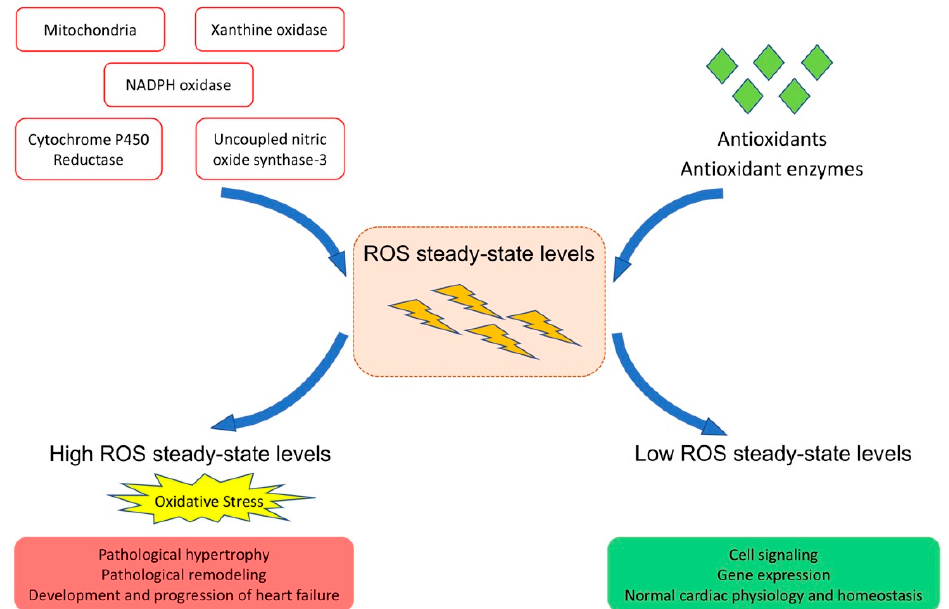
Figure 1. Role of ROS in cardiac physiology and pathophysiology. Under physiological condi- tions, there is an exquisite balance between ROS production and ROS degradation resulting in low steady-state ROS levels. Low levels of ROS have a physiological role in the modulation of excitation- contraction coupling in adaptive processes like physiological cardiac hypertrophy, and in cardiac homeostasis. Oxidative stress resulting from an increase of steady-state ROS levels results in mala- daptive processes such as detrimental effects on cardiomyocyte electrophysiology, capillary rare- faction, interstitial and perivascular myocardial fibrosis, and apoptosis. Oxidative stress contributes to pathological hypertrophy, pathological remodeling, and the development and progression of heart